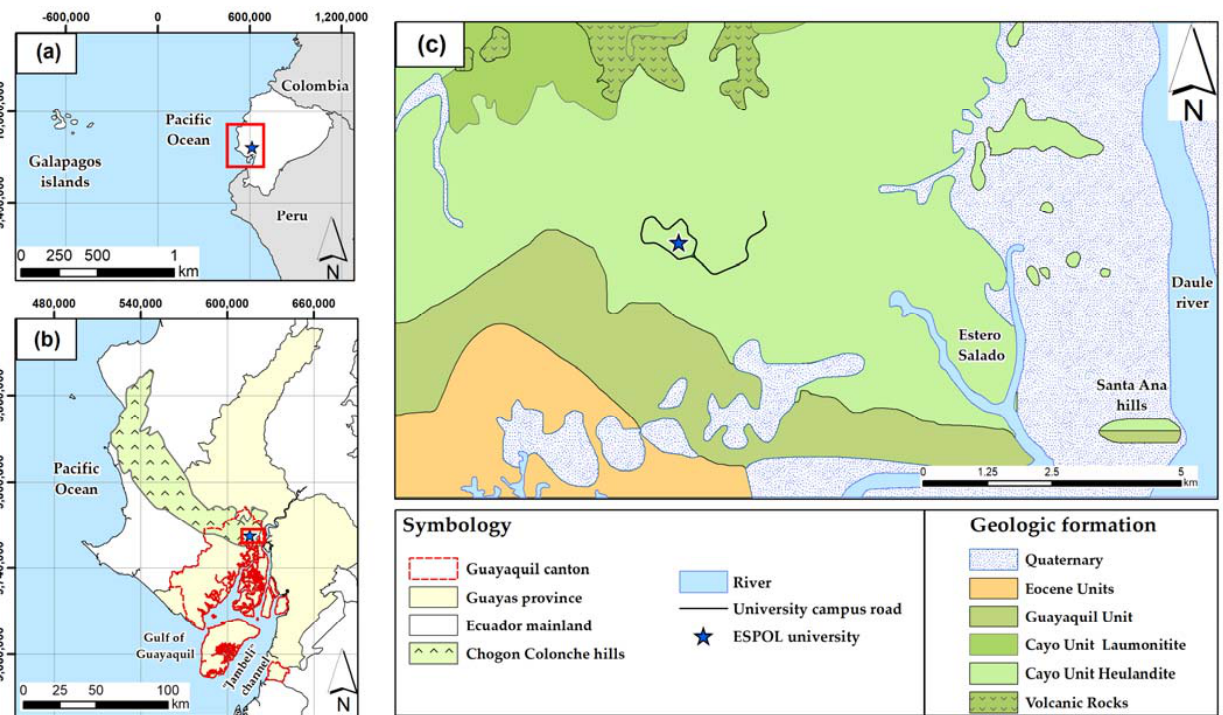
Figure 1. The geographical and geological setting: ( a , b ) regional location of the study area; ( c ) geo- logical setting showing the main geological units of the university campus.